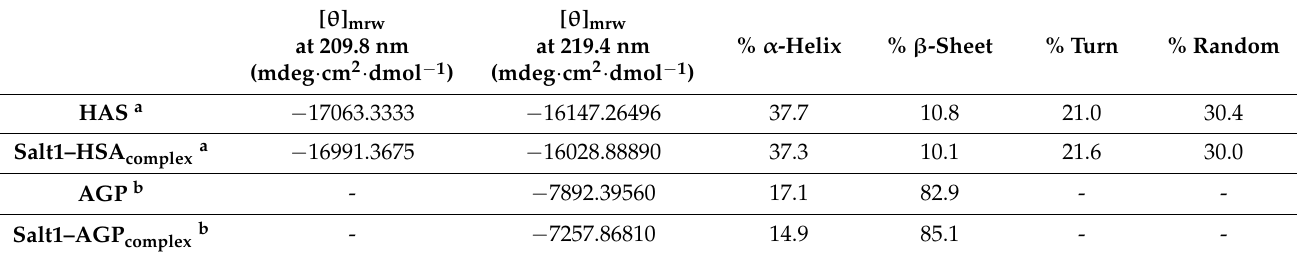
Figure 2. Far-UV circular dichroism spectra of ( a ) HSA and ( b ) AGP in the absence or presence of Salt1. Table 4. The percentage (%) content of the secondary structure elements of HSA and AGP based on Yang’s and Reed’s reference models,